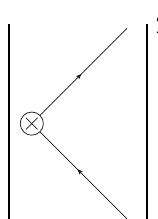
Figure 2 . Diagrammatic contribution to the O ( (cid:11) 0 diagram has to be squared and contributes only as a Dirac delta function.